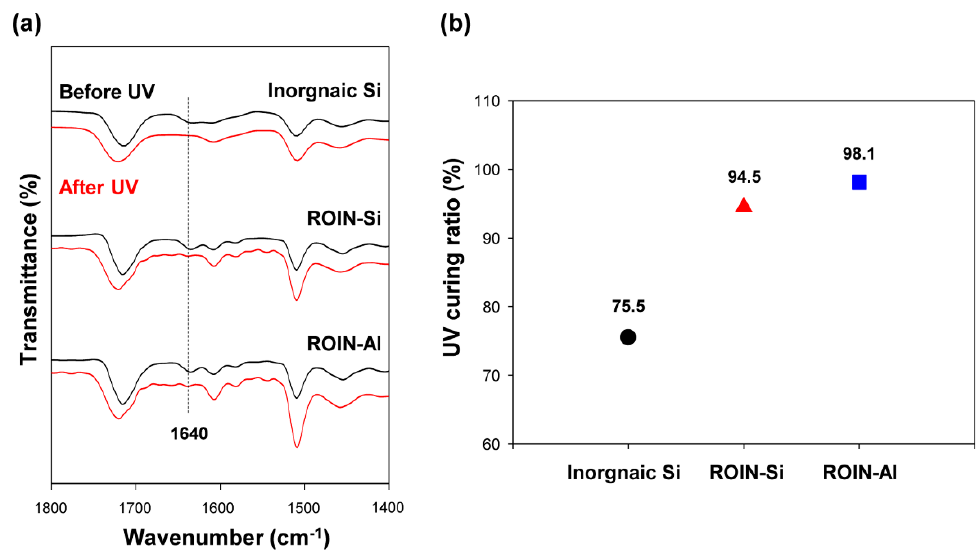
Figure 7. ( a ) FTIR spectra of the epoxy–acrylate composites containing inorganic silica or reactive hybrid nanoparticles before (black) and after (red) UV curing. ( b ) UV curing ratios of the composites with inorganic silica or reactive hybrid nanoparticles.